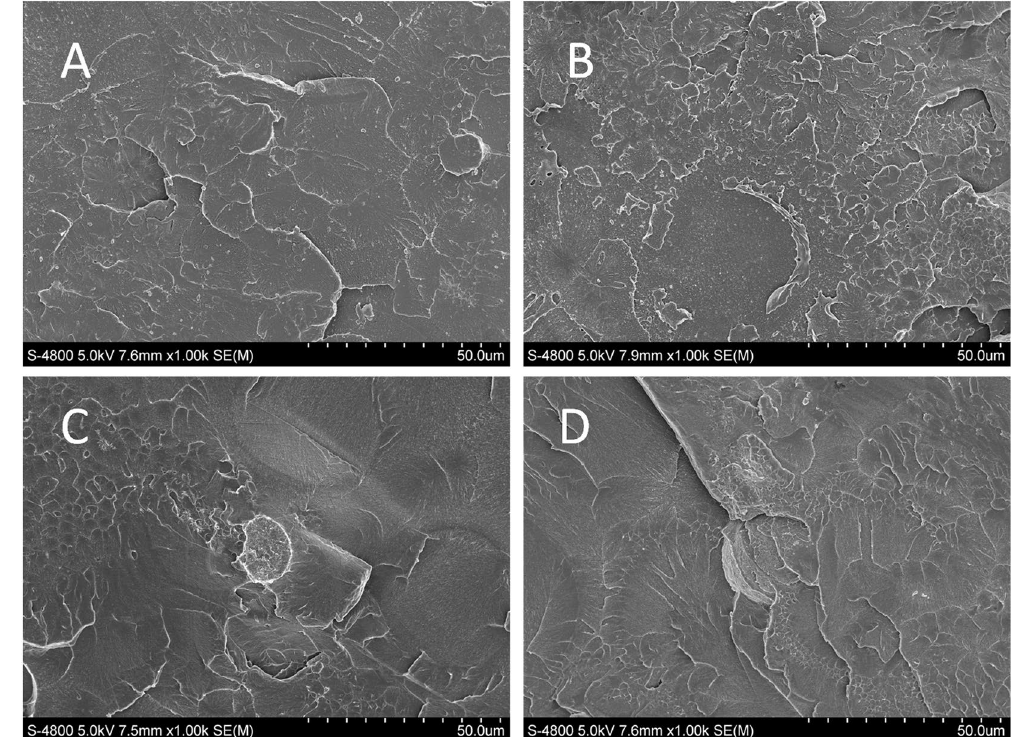
Figure 11. Fe-SEM images of fracture surfaces of ( A ) pure PMMA resin, and PMMA resin filled with different AgBr/NPVP loadings. ( B ) 0.1 wt%, ( C ) 0.2 wt%, ( D ) 0.3